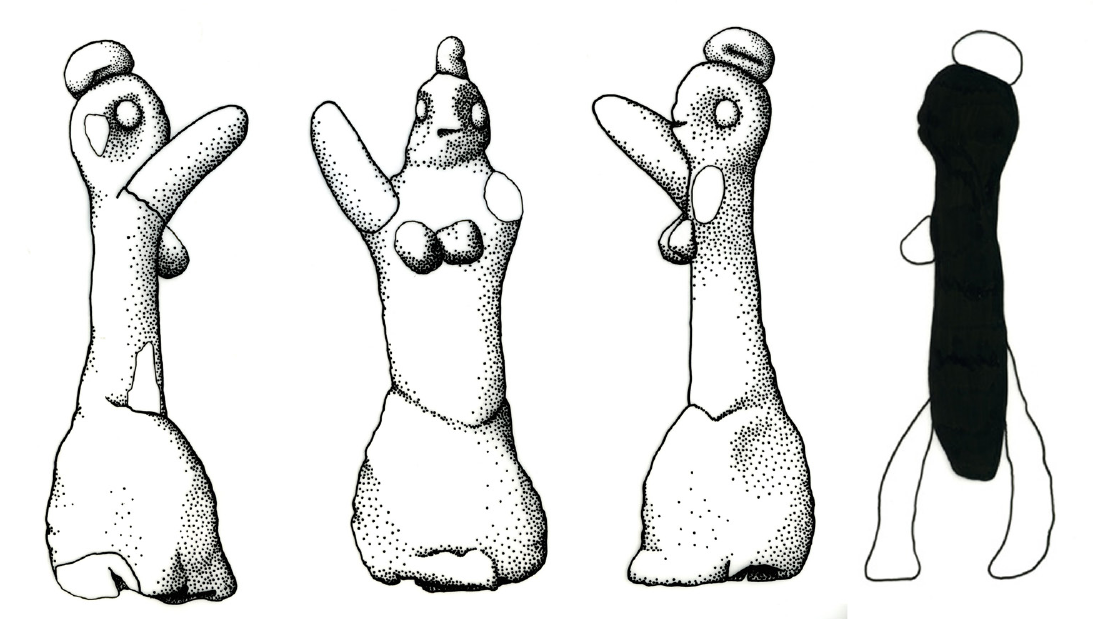
Figure 2. Female terracotta figure from Atsipadhes, drawn by Jenny Doole. Three views and a section to show pegged construc- tion of torso and skirt. (RM 6785, with joining fragment, RM